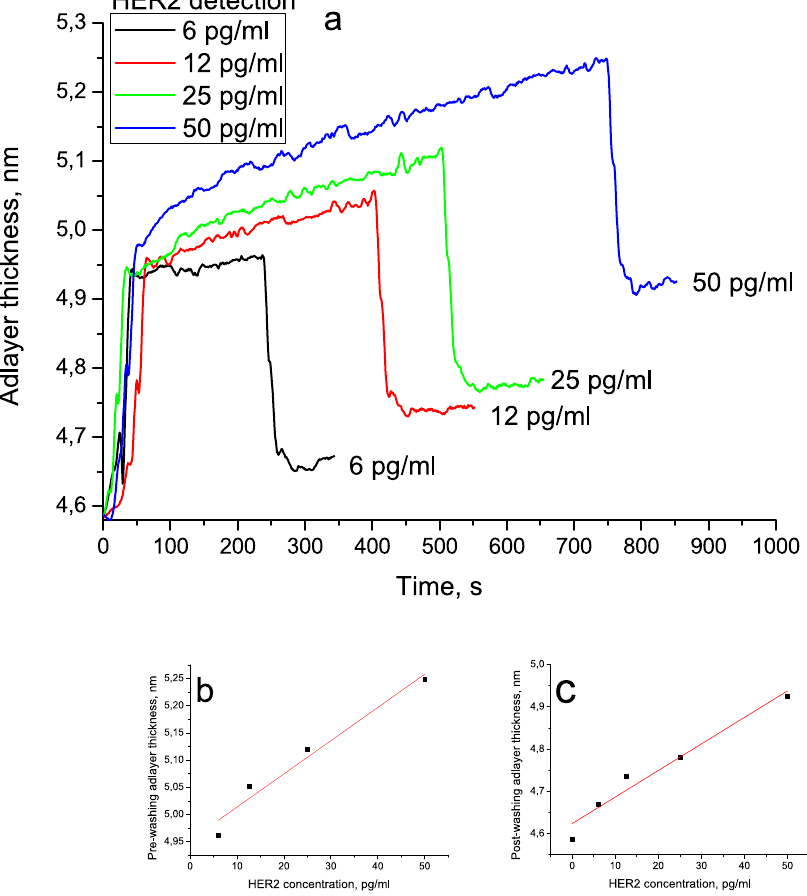
Figure 5. Quantitative detection of HER2 antigen using photonic crystal surface mode detection. ( a ) The dependence of the adlayer thickness increase and decrease on the HER2 concentration; after the start of the HER2 flow, the signal was allowed to reach a plateau (pre-washing adlayer thickness); then, the solution was switched to PBS to begin the washing stage; the washing stage was marked with a rapid decrease in the signal intensity until it reached a new plateau (post-washing adlayer thickness). ( b ) The linear dependence of the pre- washing adlayer thickness on the HER2 concentration. ( c ) The linear dependence of the post-washing adlayer thickness on the HER2 concentration (the value before HER2 binding taken to be the zero